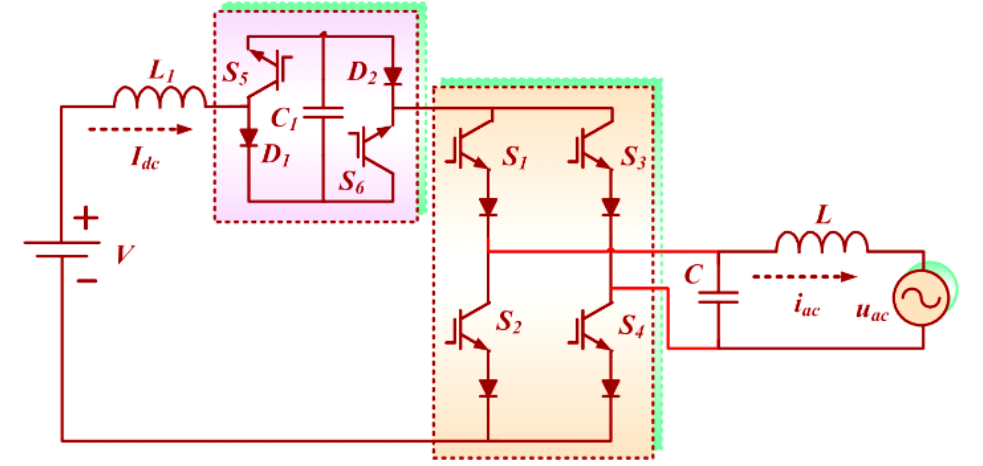
Figure 3. ( a ) H-bridge decoupling circuit; ( b ) Simplified H-bridge decoupling circuit.